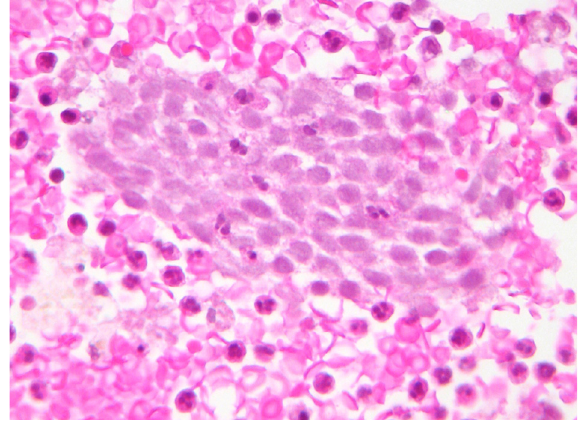
Figure 1. Presence of epithelial cells (arrows) (H&E